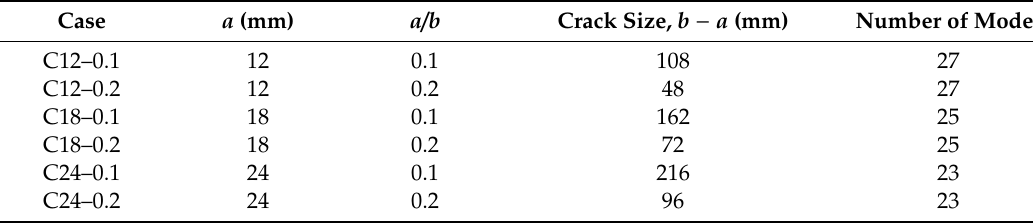
Table 2. Designed crack geometry and simulation numbers by the wavenumber